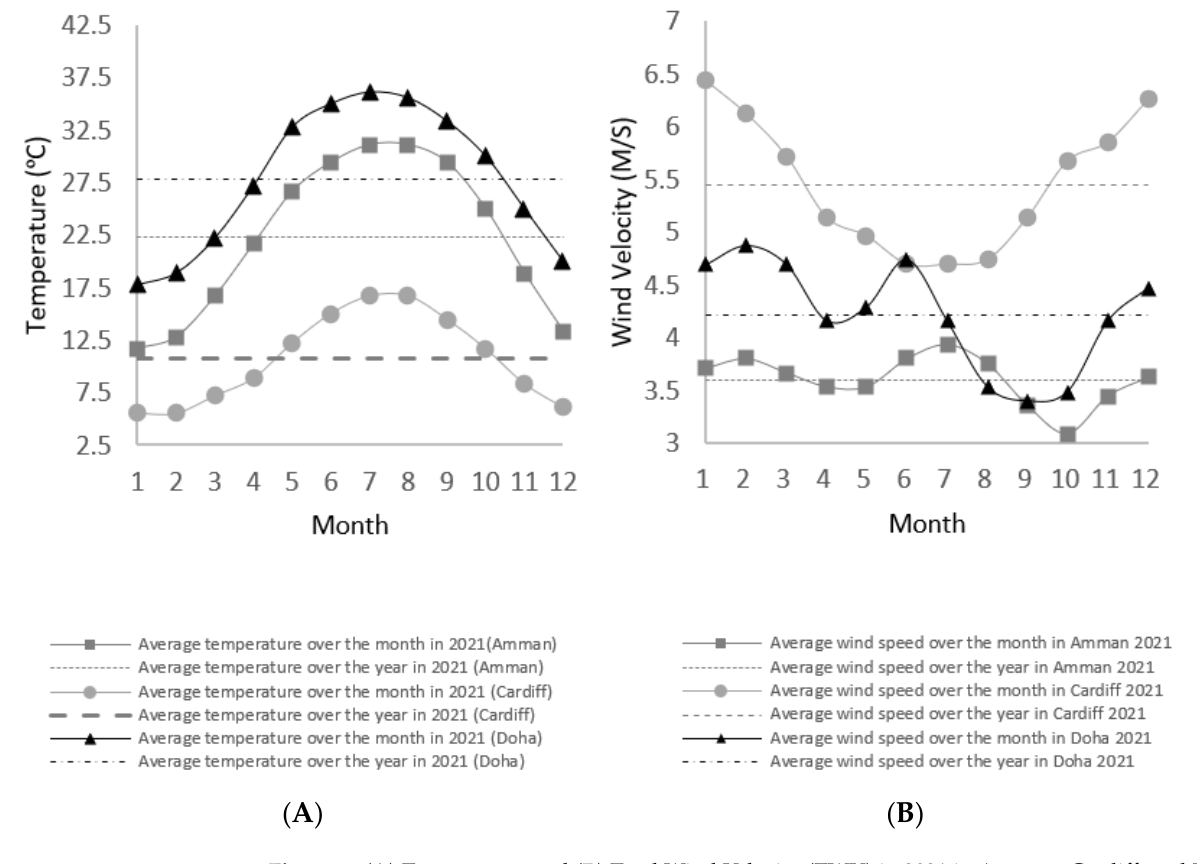
Figure 4. ( A ) Temperature and ( B ) Total Wind Velocity (TWV) in 2021 in Amman, Cardiff, and Doha.